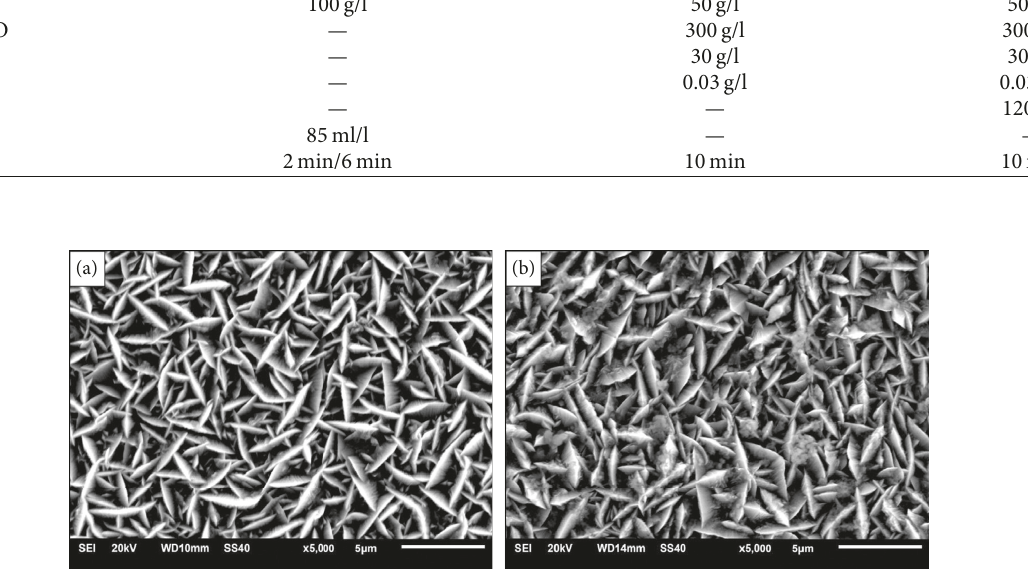
Figure 1: Surface morphology of the as-deposited coatings: (a) pure Co coating and (b) Co-Mn